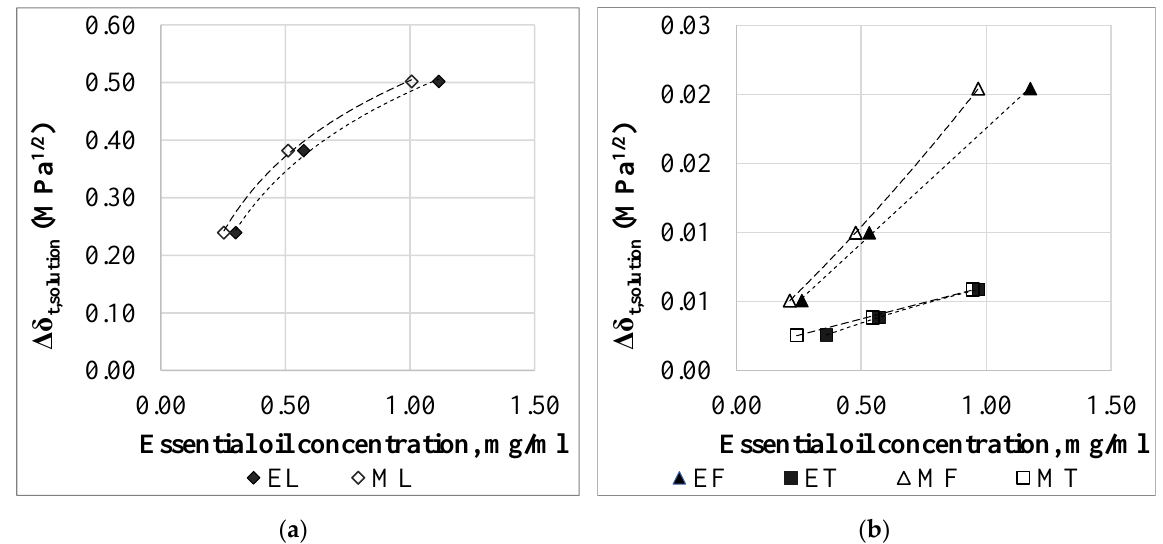
Figure 9. The change of the HSP parameters depending on the essential oil concentration in the case of ( a ) lemongrass essential oil; ( b ) thyme and fennel essential oils. The specific amount of essential oil adsorbed on the PLA can be also related to the HSP and its components. Essential oils of different compositions have different solubility parameters depending on their composition (Table 2). Consequently, the specific essential oil uptake of PLA is different for different essential oils. In ethanol solution, we found a correlation between the adsorbed amount of the essential oil and ∆ δ t , EO . The ∆ δ t , EO shows how much the total solubility parameter of the EO differs from the solubility parameter value for PLA . In 1.00 mg/mL and 0.50 mg/mL concentration solutions, as the value of the ∆ δ t , EO increases, the amount of adsorbed essential oil increases (Figure 10a). The opposite effect was found in the case of the 0.25 mg/mL concentration solution: as the value of the ∆ δ t , EO increases, the amount of adsorbed essential oil slightly decreases. However,